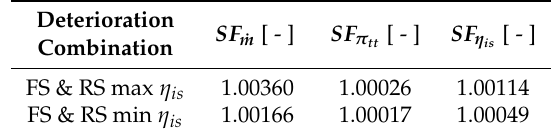
Table 3. Values of scaling factors used.